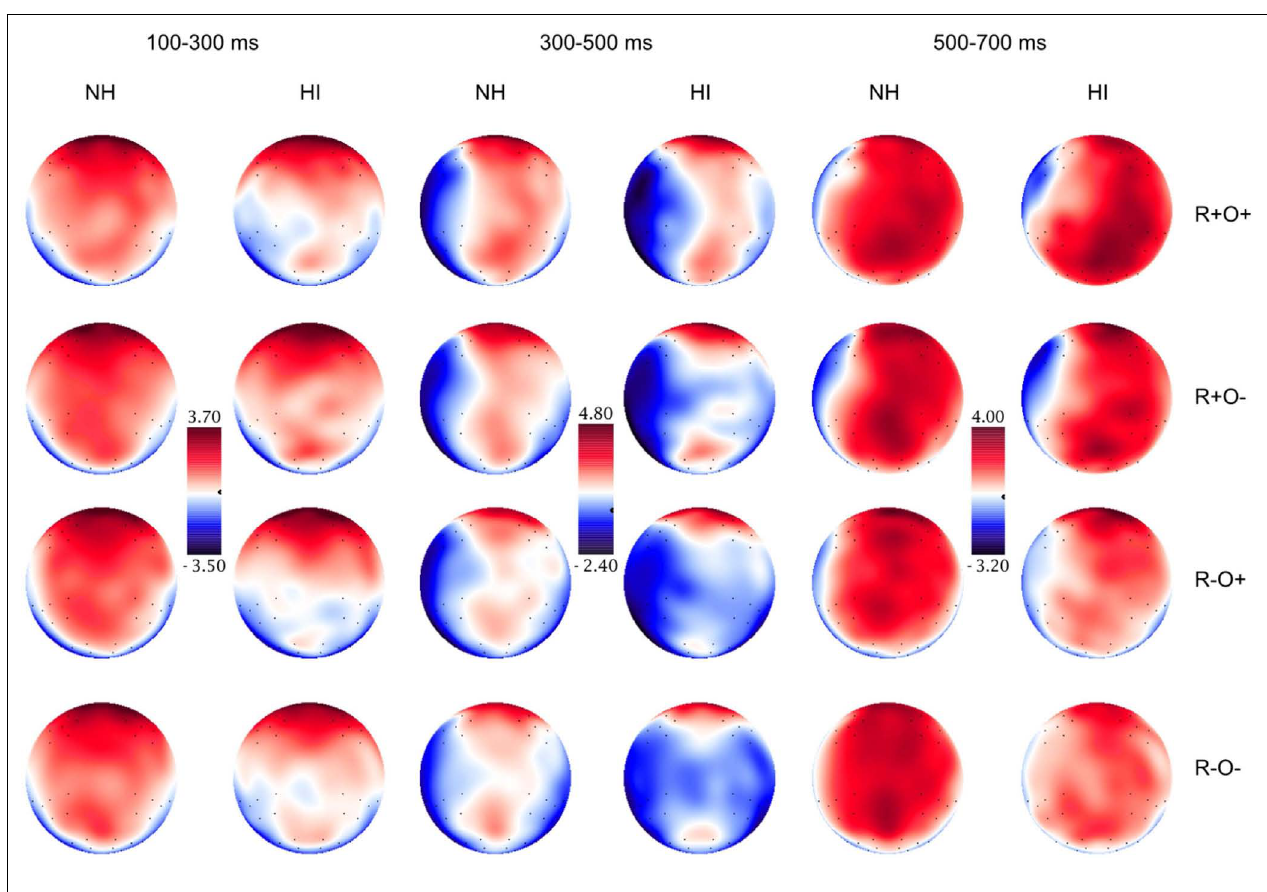
FIGURE 8 |Topographical distribution of the grand averaged ERPs in the normal hearing (NH) and hearing-impaired (HI) groups in the 100–300, 300–500, and